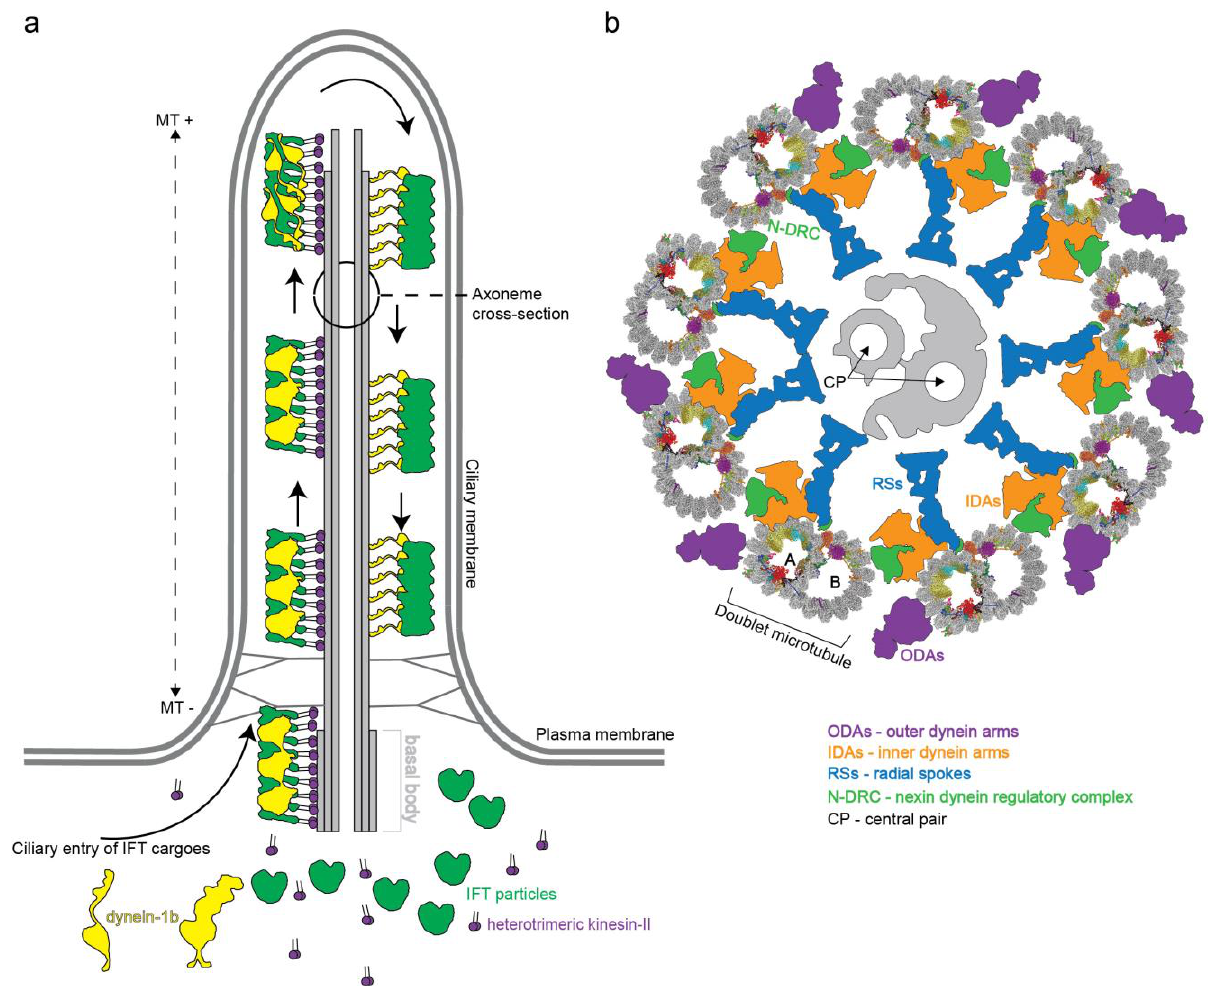
FIGURE 1: Schematic representation of a cilium from Chlamydomonas reinhardtii . (a) Architecture of a cilium with a simplified scheme of the bi-directional intraflagellar transport (IFT) system trafficking proteins between the cilium and the cell body. IFT complexes (green) as- semble into train-like polymers powered by heterotrimeric kinesin-II (purple) in the anterograde direction (base->tip). Inactive dynein-1b (yel low) is loaded as a cargo onto anterograde IFT ‘trains’. Once assembled and loaded with ciliary cargo, these trains are drive n across the transition zone and Y-links (depicted as grey connections spanning from the ciliary membrane to the axoneme at the ciliary base) to reach the ciliary tip. Upon arrival at the ciliary tip, the IFT ‘trains’ are re -modelled, turnover products are picked up and moved back again to the ciliary base by retrograde IFT powered by the now activated dynein-1b motor. (b) Schematic representation of an axoneme cross section of a motile cilium, which depicts the nine peripheral doublet microtubules (DMTs; PDB entry: 6u42) that surround a central microtubule pair (CP, shown in grey). The DMTs are connected though the nexin dynein regulatory complex (N-DRC, shown in green). Complexes responsible for ciliary beating are the inner- and outer- dynein arms (IDAs and ODAs; orange and magenta, respectively). The central pair is connected to the nine DMTs by radial spokes (RS;